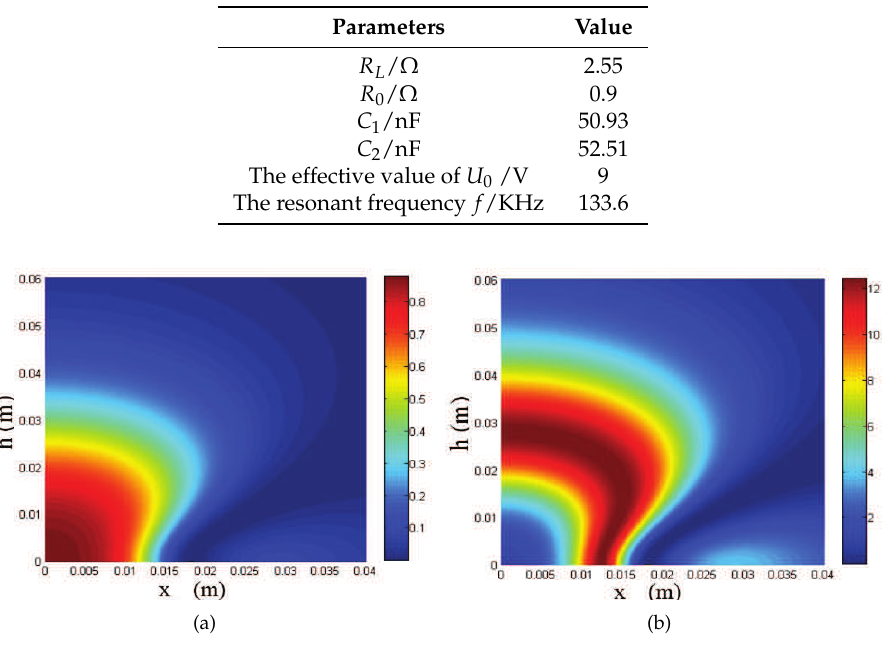
Figure 7. ( a ) Relationship of the distance between the two coils and transfer efficiency in the resonant state; ( b ) Relationship between the two coils and the load power in the resonant